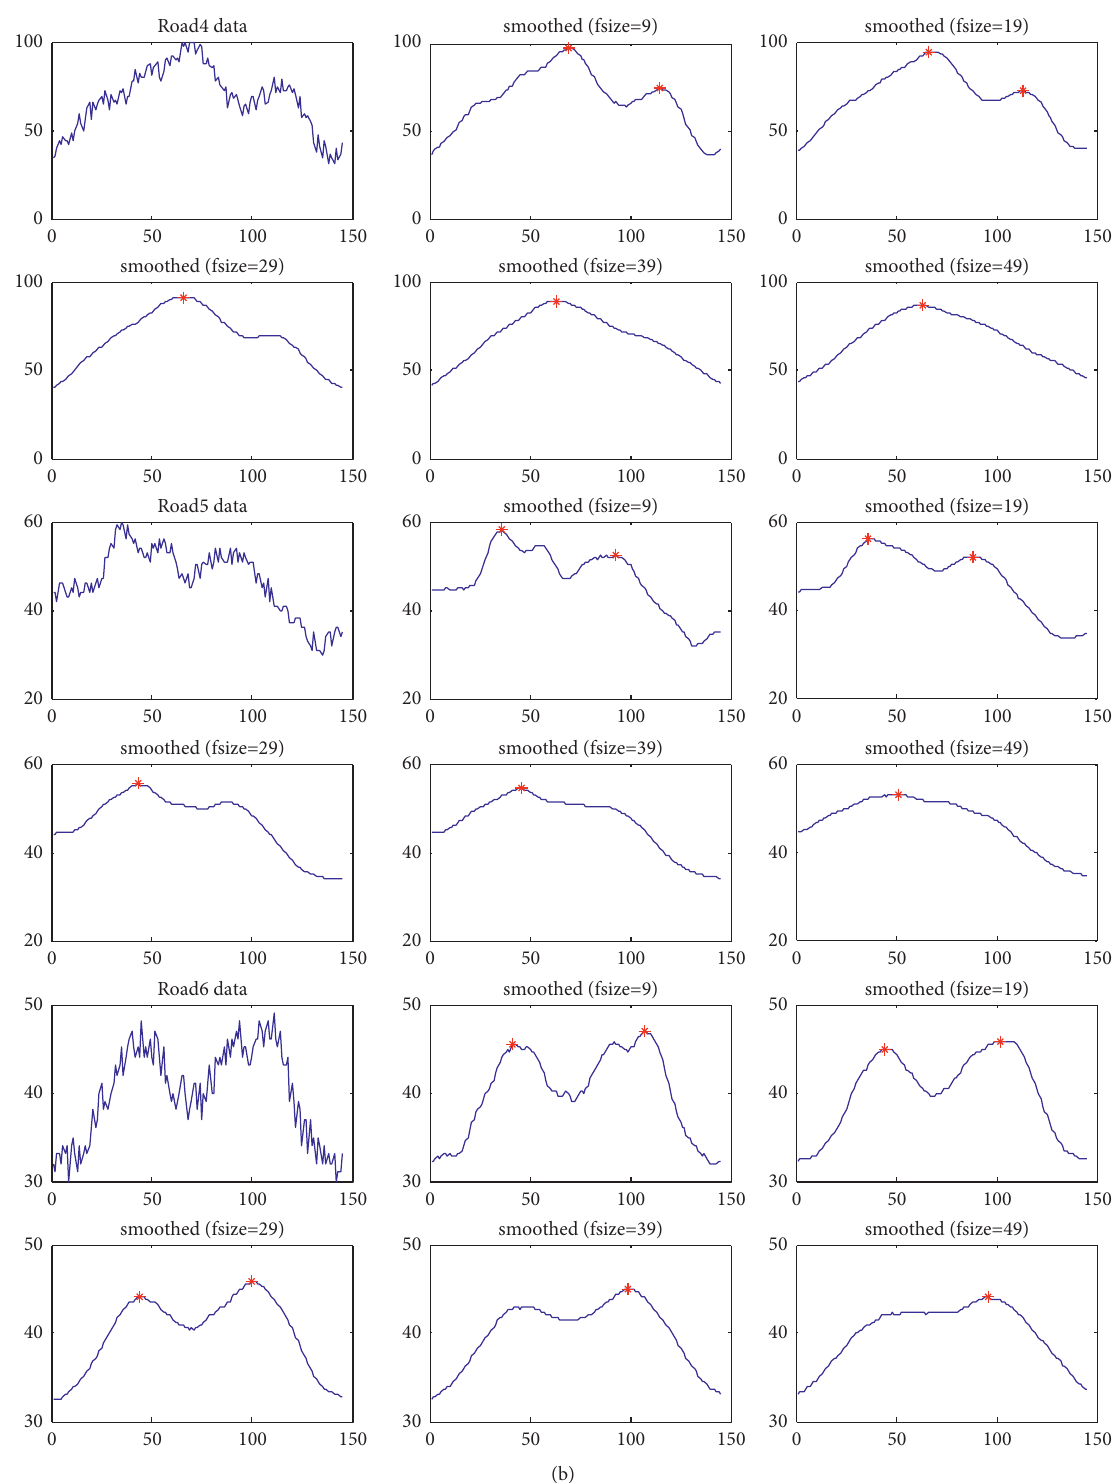
Figure 15: The data smoothed by the average filter and the peaks picked by Billauer’s method on the smoothed data. For each time series, we list the original data, followed by the smoothed data with the 5 filter sizes (fsize). In this and the following figures, the x-coordinates represent the time in unit of 5